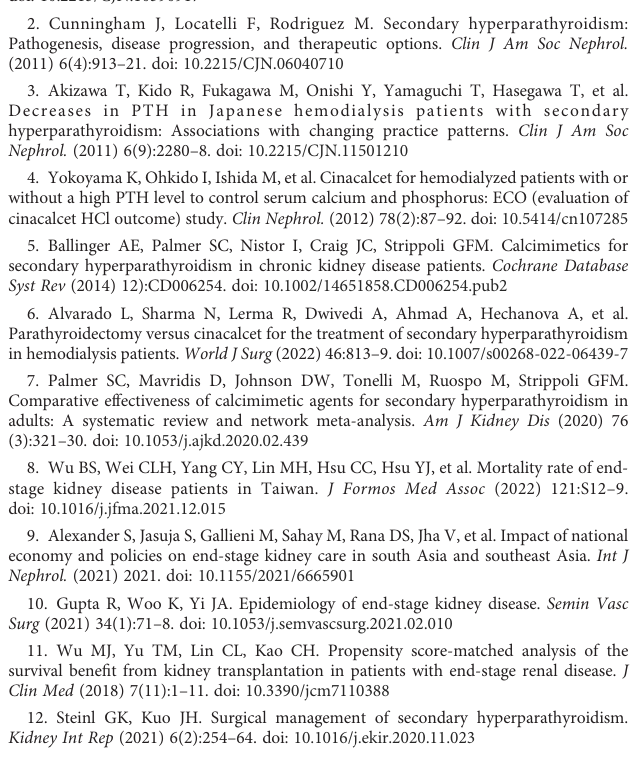
SUPPLEMENTARY FIGURE 1 Cumulative incidence of SHPT recurrence and death without SHPT recurrence in ESRD patients after primary parathyroidectomy, namely, the fi rst-time parathyroidectomy. The incidence of death without SHPT recurrence within 5 years was